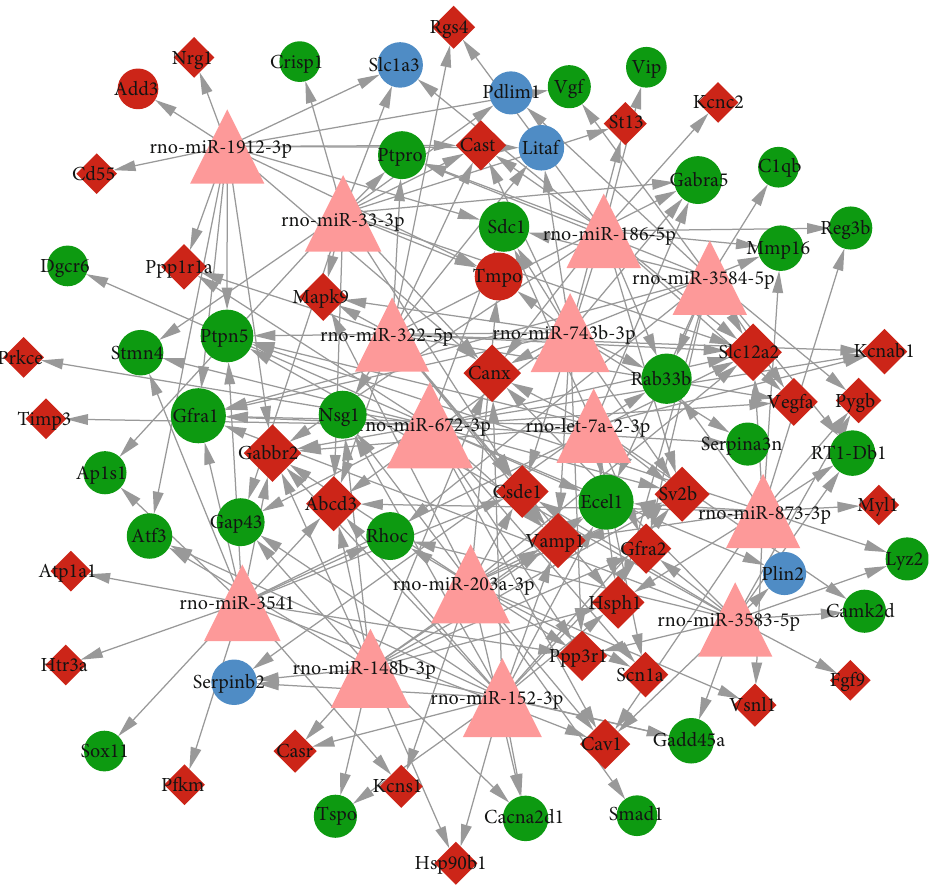
Figure 5: The miRNA-target regulatory network. Red nodes represent cluster 1 genes, blue nodes represent cluster 2 genes, and green nodes represent cluster 3 genes. Circle nodes represent upregulated genes, and rhombus nodes represent downregulated genes. The pink triangle nodes represent the predicted miRNAs with the number of targetgenes ≥ 15 . The gray lines represent target gene regulation by